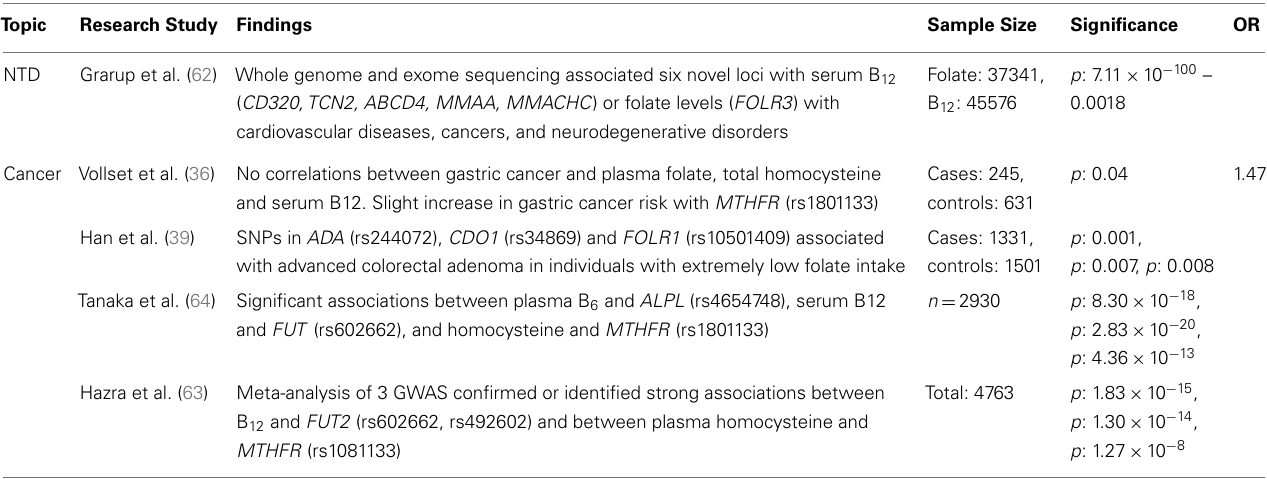
Table 4 | Major findings observed in association studies examining folate and vitamin B 12 metabolic pathway genes, using GWAS, major diseases and dietary folate and B 12 dietary intake, including sample size, significance (as p or 95% confidence interval), and risk measurement (Odds ratio, OR)